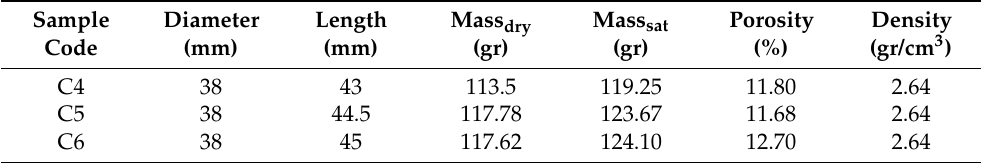
Table 3. Properties of Low-porosity sandstone specimens for AVS apparatus.